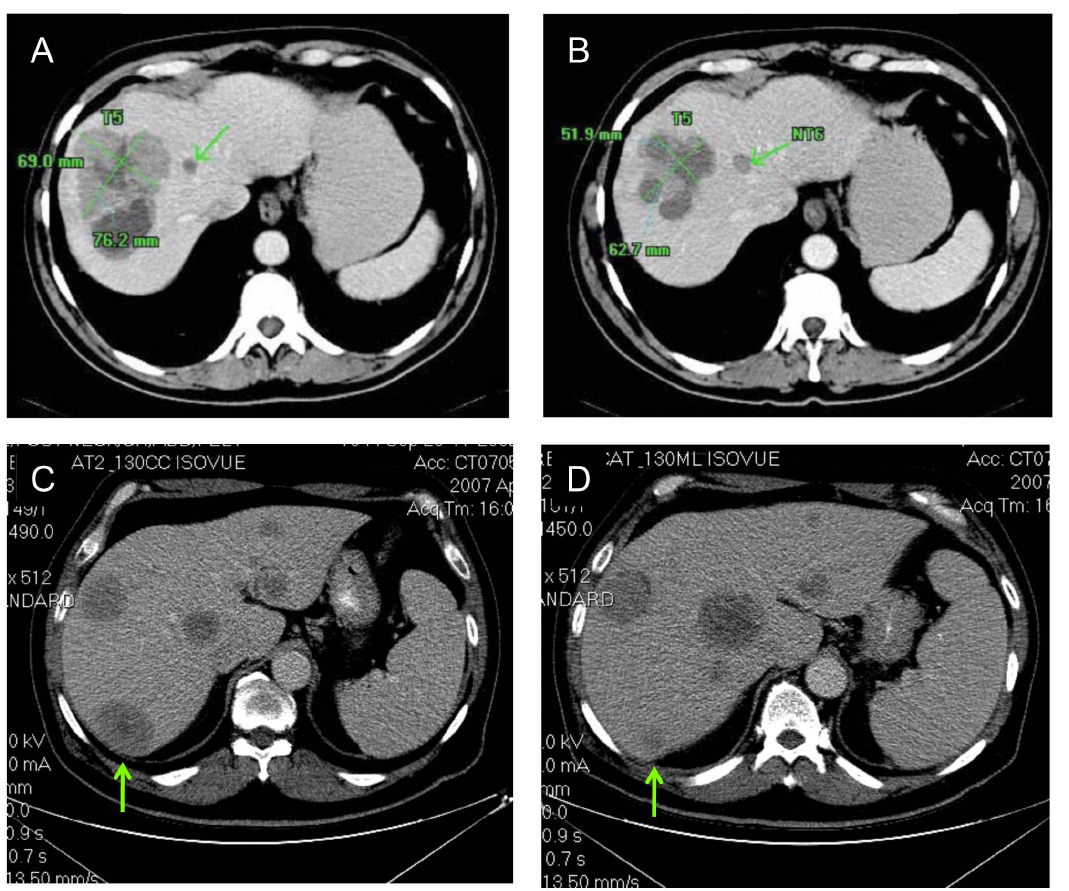
Figure 3. Mixed-tumor responses in patients with metastatic melanoma receiving GC1008. Patient 003 was previously treated with dacarbazine and sorafenib and then received GC1008 0.1 mg/kg 6 4 doses followed by 1 mg/kg 6 4 doses on Extended Treatment. Representative CT scans comparing baseline (Panel A) and day 112 (2 months post Extended Treatment, Panel B) demonstrate a reduction in size of a liver metastasis (arrows) with features consistent with increased necrosis and cyst formation; however, a pulmonary hilar lesion demonstrated growth (not shown). Patient 008 was previously treated with multiple surgeries, high dose interleukin-2, and an investigational anti-melanoma vaccine and then received GC1008 1 mg/kg 6 4 doses followed by 3 mg/kg 6 4 doses on Extended Treatment. Comparison of CT scans from baseline (Panel C) and day 91 (Panel D) demonstrate near resolution of a liver metastasis (arrows); however, growth was noted in other hepatic lesions.